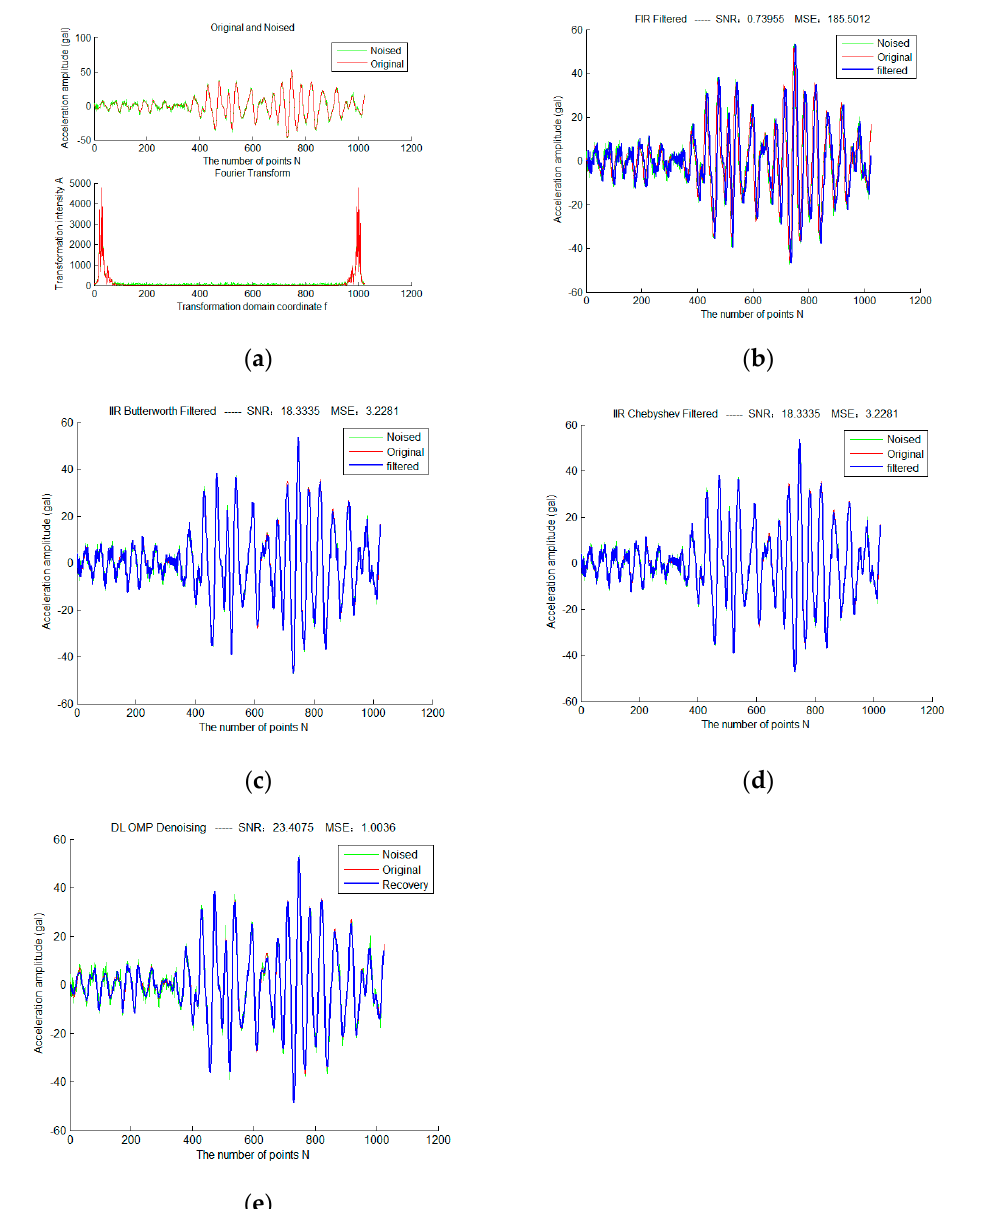
Figure 12. The Spare Denoising Experiment of a Frame of Strong Earthquake Signals Based on the Learning-type Dictionary ( a ) is the original and noise-adding waveforms of the frame signal in the time and frequency domain (sigma = 10); ( b ) is the result based on FIR filtering; ( c ) is the result based on Butterworth filtering; ( d ) is the result based on Chebyshev filtering; ( e ) is the OMP sparse representation denoising result based on the learning-type